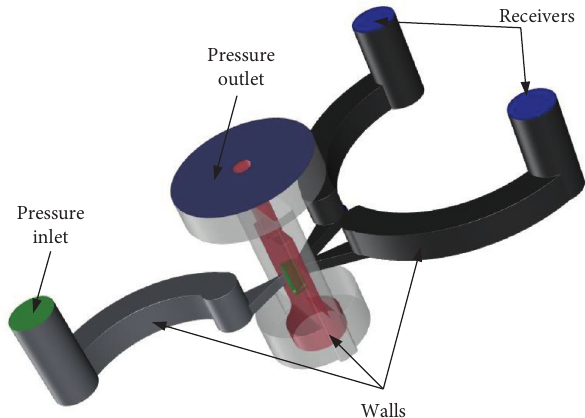
Figure 3: Numerical calculation model of the